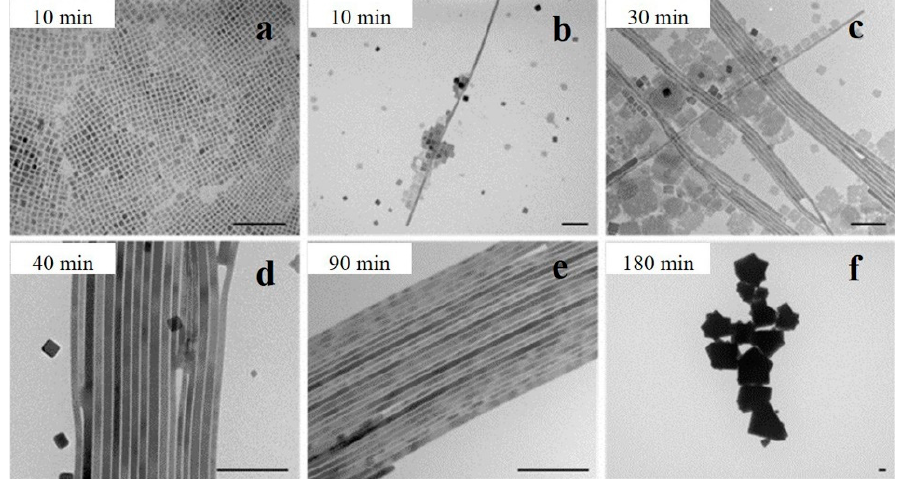
Figure 2. TEM images of the CsPbBr 3 nanostructures synthesized with different reaction times: (a) less than 10 min, (b) after 10 min, (c) 30 min, (d) 40 min, (e) 90 min, and (f) 180 min. Scale bar: 100 nm. Reprinted with permission from reference [16]. Copyright 2015, American Chemical